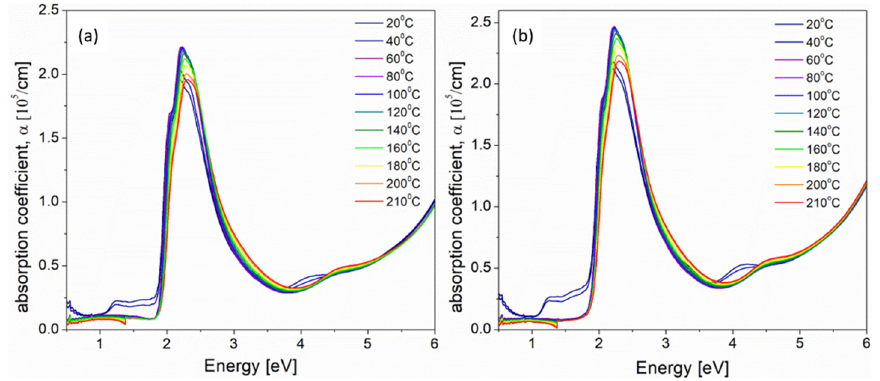
Figure 4. Absorption coefficient spectra, measured at different temperatures, within the whole UV- Vis-NIR spectral range, of iodine-doped P3HT thin films with ( a ) 5% and ( b ) 10% mol.